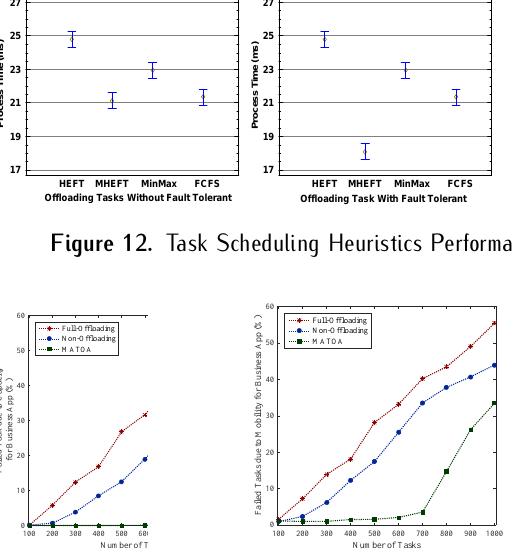
Figure 13. Business Application Performance Without and With Mobility